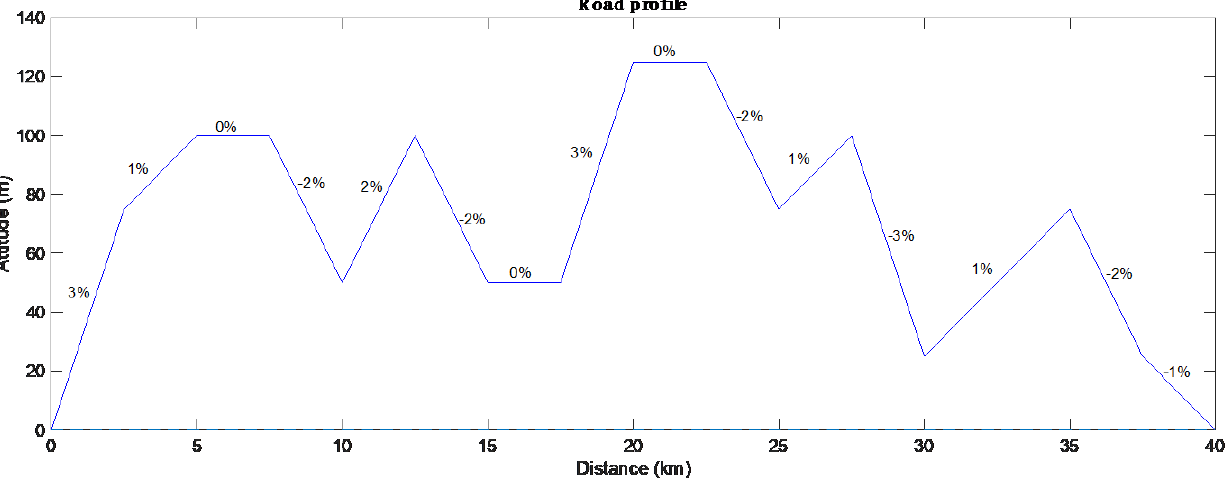
Figure 2. Profile of road segments with different grades.